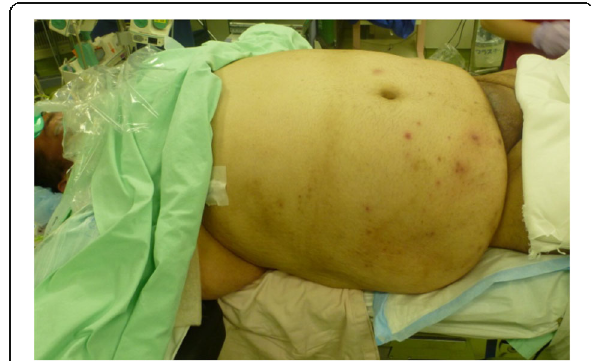
Fig. 3 First-stage surgery. The patient was morbidly obese and difficult to rotate on the operating table